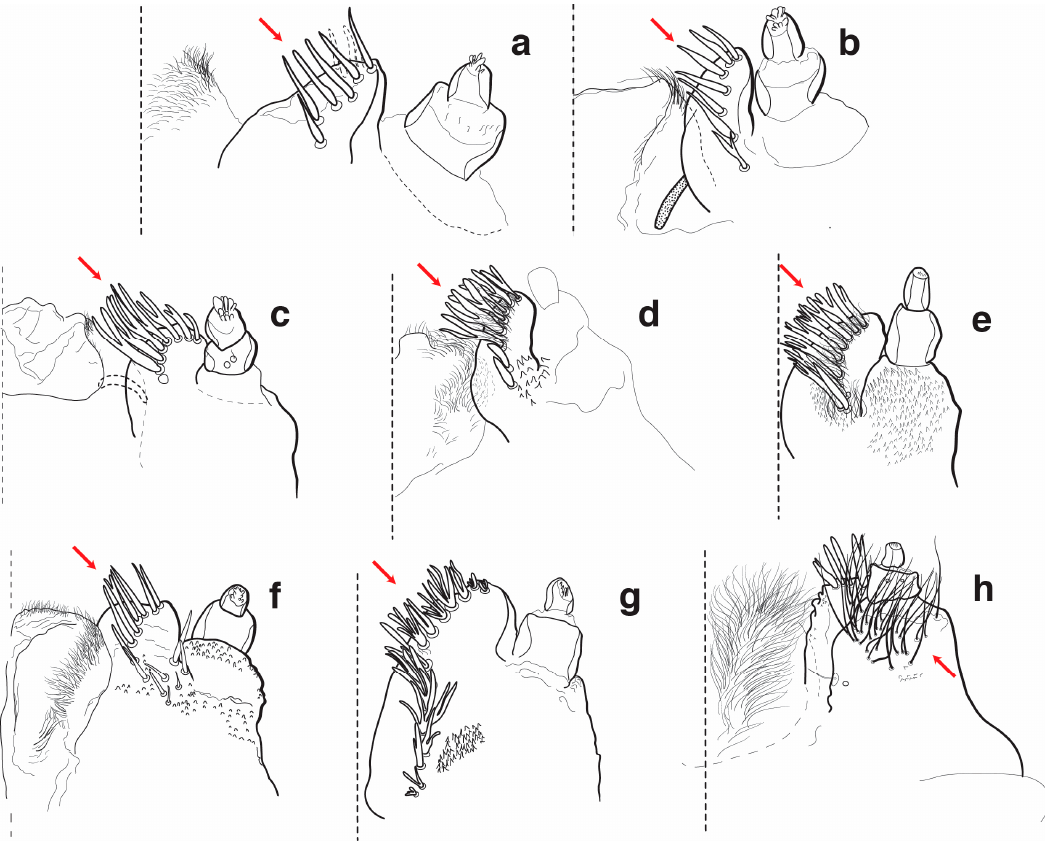
Figure 45. Hypopharynx, mala and maxillary palp, larva, dorsal view: ( a ) Tryphetus ; ( b ) Myocalandra ; ( c ) Stenommatus ( d ) Eucalandra ; ( e ) Odoiporus ; ( f ) Rhynchophorus ; ( g ) Sipalinus ; and ( h ) Cyrtotrachelus . 6. Shape of dorsal malar setae (dms) (if at least one is branching, select b, see next couplet) (Figure 46)